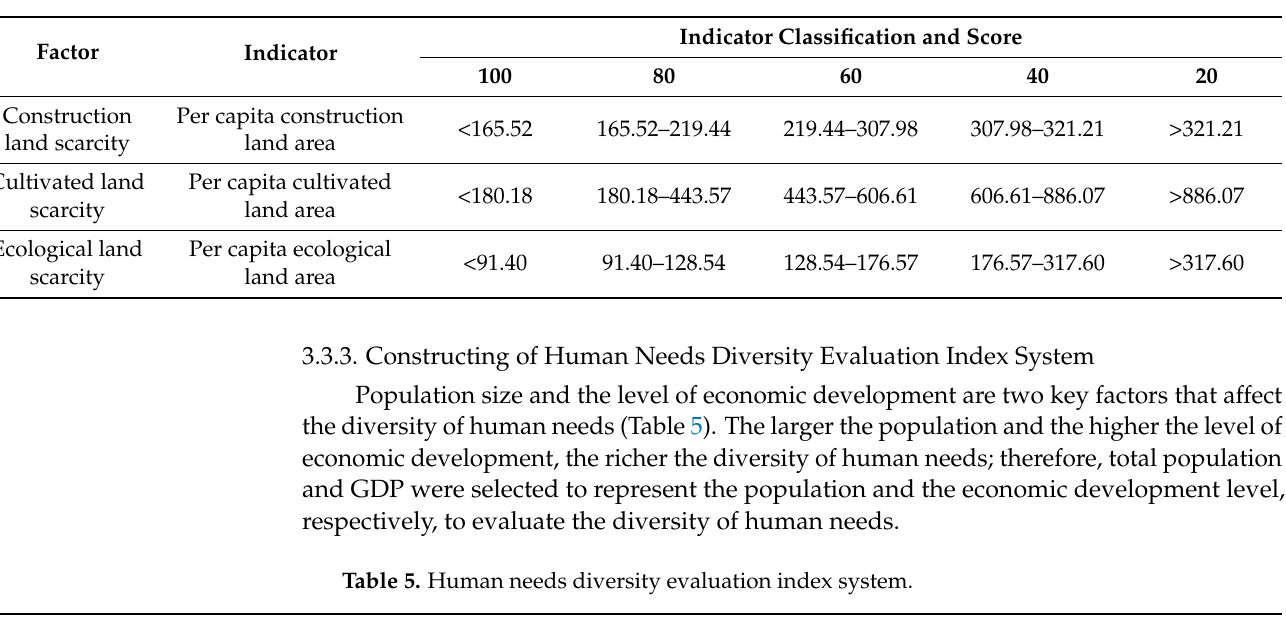
Table 4. Evaluation index system for land resource scarcity.